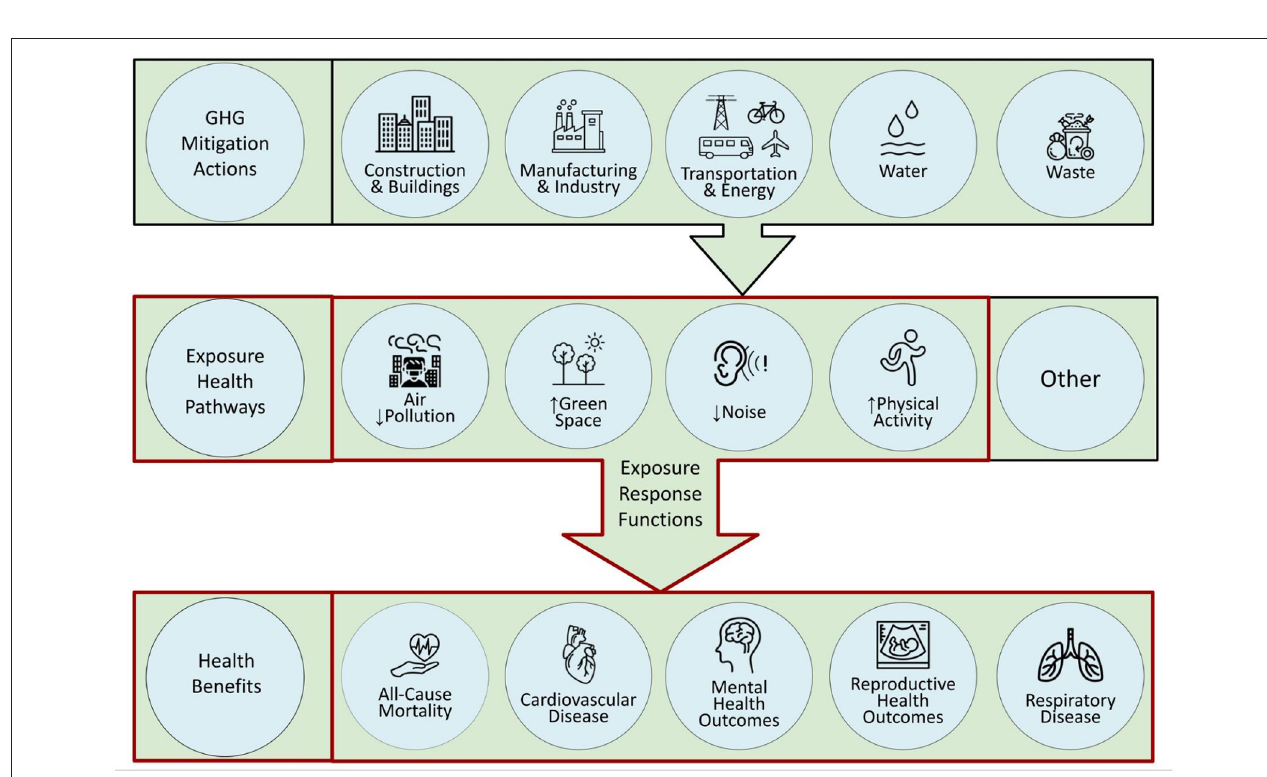
FIGURE 2 | Overview of pathways by which climate mitigation actions in cities can lead to health benefits. The portions outlined in red are the subject of the current paper.